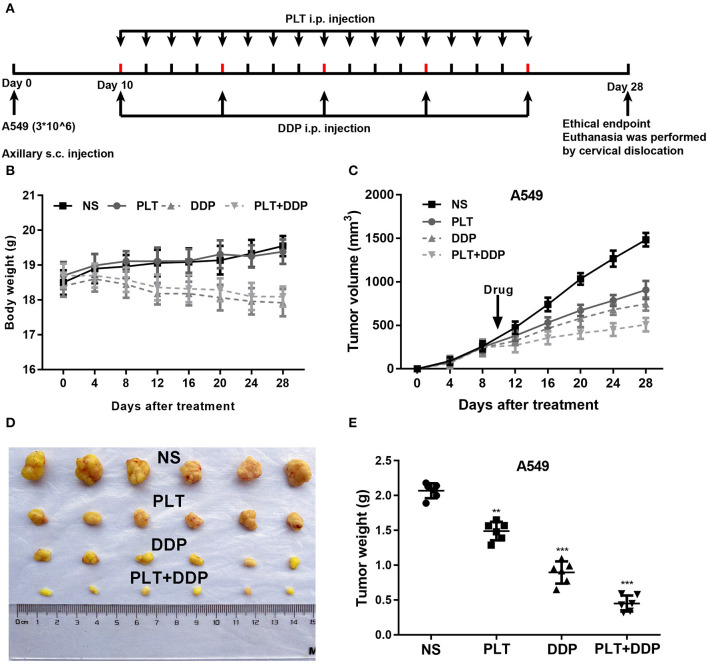
PTL combined with DDP inhibits NSCLC xenograft tumor growth. Time line of NSCLC cell inoculation and drug treatment (A). Time courses of animal weight (B). The tumor volume of all groups was measured every 4 days, beginning the first day after injection until the study end point (C). Tumors derived from A549 cells in six male nude mice are presented (D). The tumor weight of all groups was measured and compared, ***P < 0.001 vs. the control group (E). Data are presented as mean ± SD. **P < 0.01 or ***P < 0.001. N = 5 in each group.